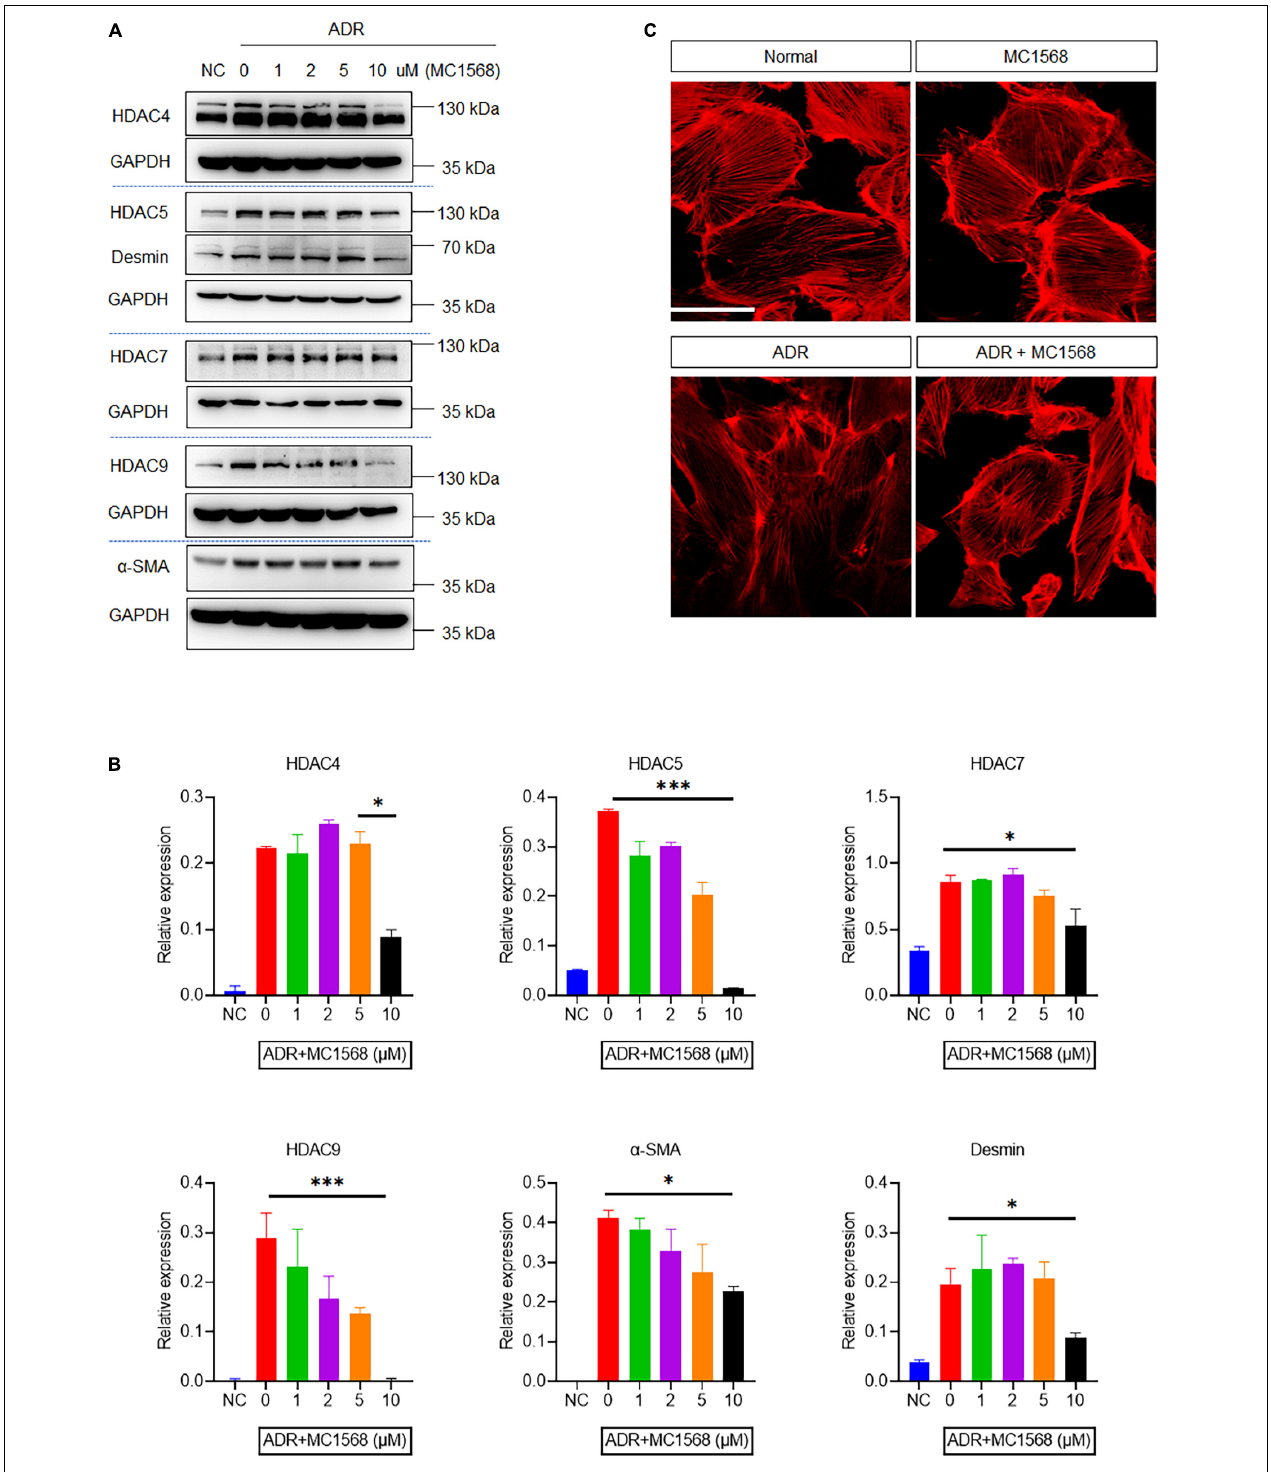
FIGURE 4 | Histone deacetylase IIa inhibition with MC1568 protects podocyte from injury in vitro . (A,B) Immunoblotting and quantification analysis of HDAC IIa members, desmin and α -SMA in ADR-stimulated podocytes with or without MC1568 treatment. (C) Phalloidin staining in ADR-stimulated podocytes with or without MC1568 treatment. Scale bar, 50 µ m. Statistical analysis was performed with two-way ANOVA. ∗ p < 0.05; ∗∗ p < 0.01; ∗∗∗ p < 0.001.